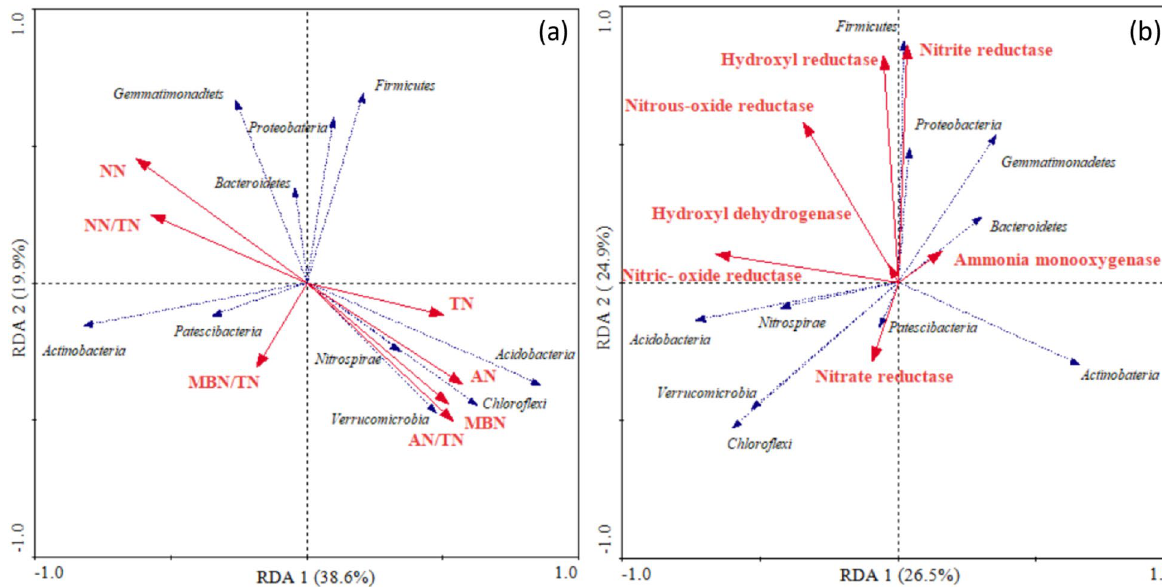
Fig. 4 Redundancy analysis (RDA) of the composition of the soil bacterial community and a soil nitrogen availability and b the related enzyme gene expression (phylum level)